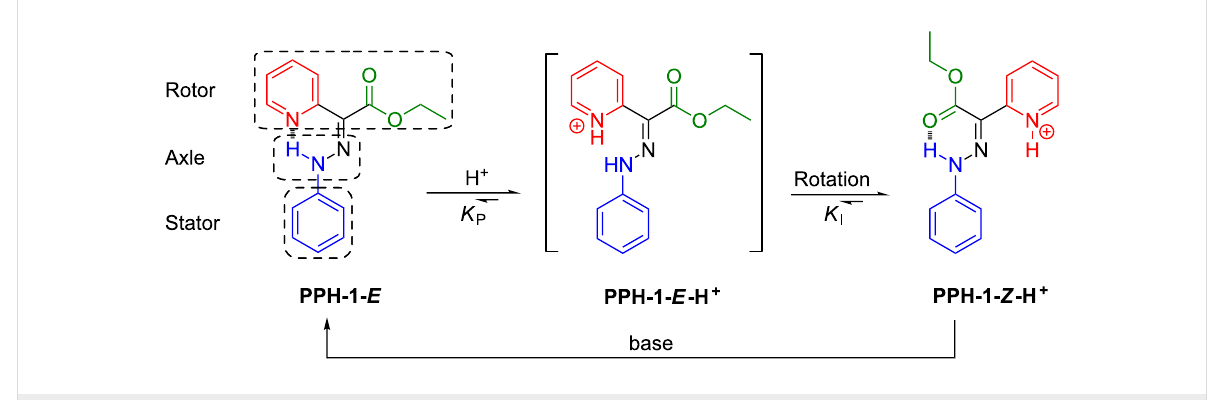
Scheme 1: The acid-activated switching process of PPH-1 .